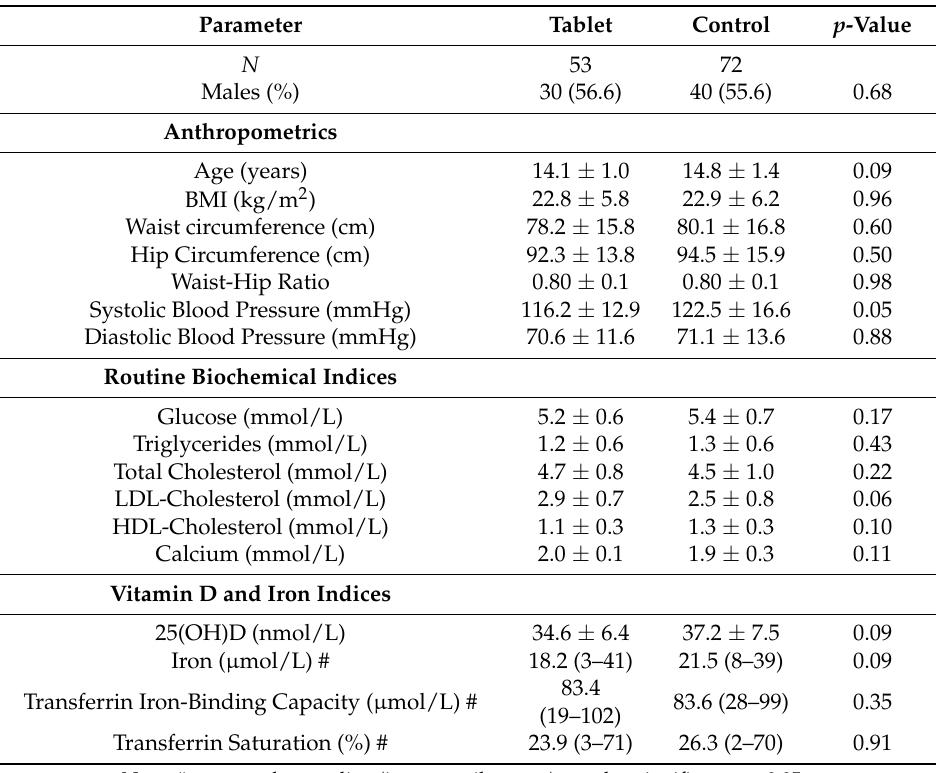
Table 1. Baseline characteristics of intervention and control